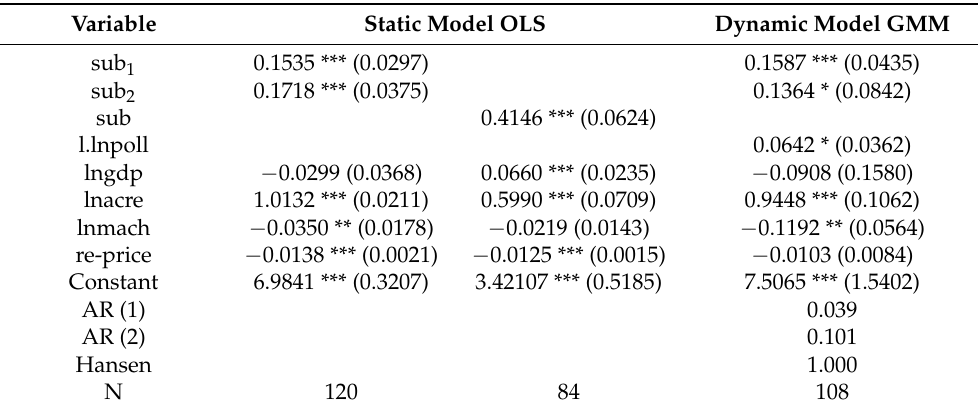
Table 5. Empirical results of the ecological and environmental effect of cotton subsidies in 12 provinces in China from 2011 to